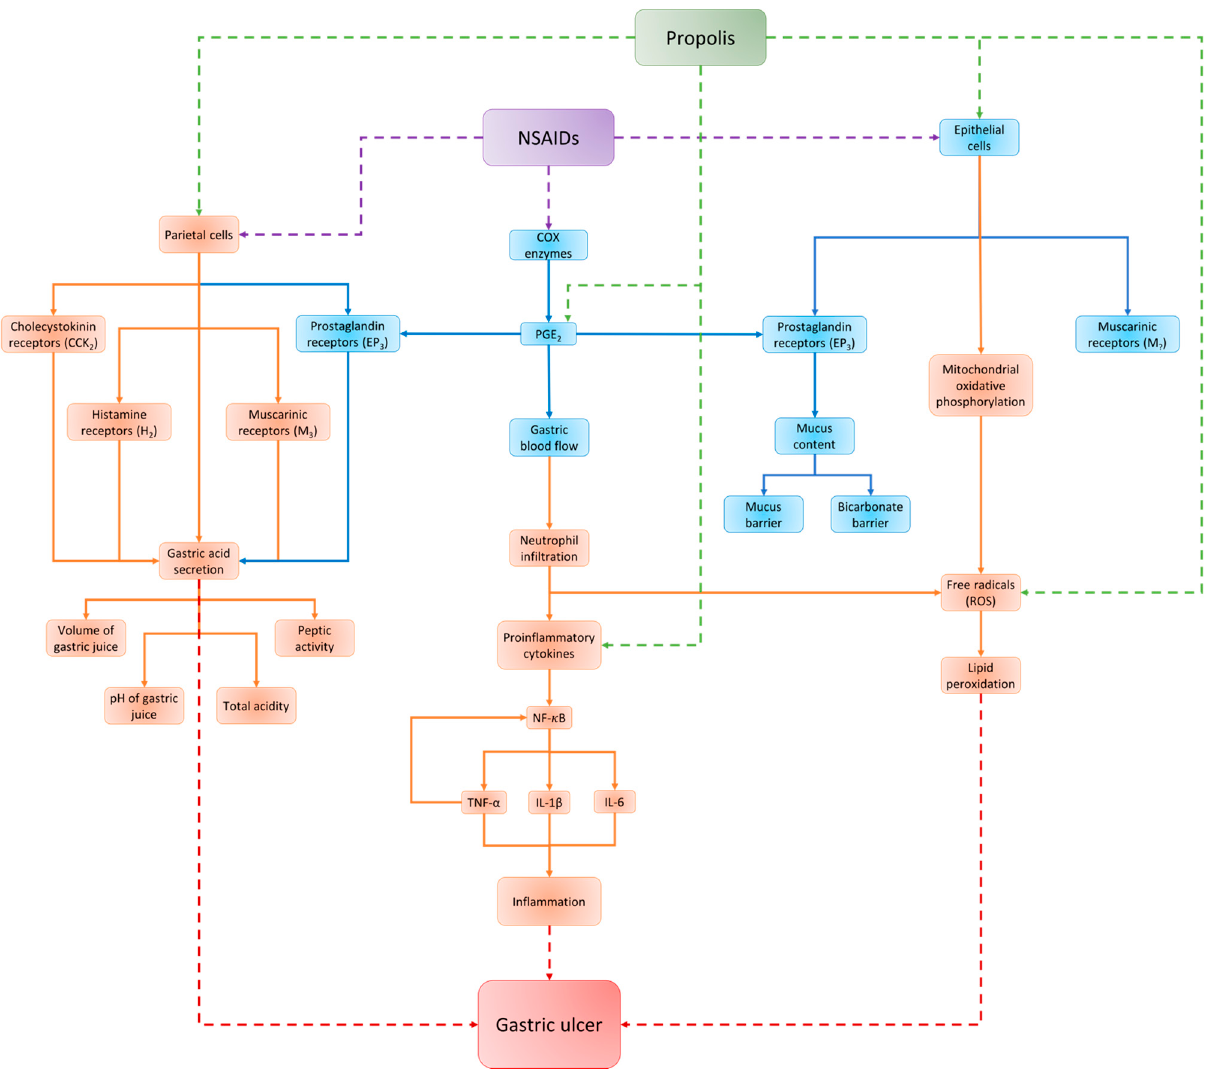
Figure 3. Harmful and protective factors implicated in the development of gastric ulcers. Blue boxes and arrows show the protective factors of the gastric mucosa, whereas orange boxes and arrows show harmful factors involved in the develop- ment of gastric ulcers. The purple dashed arrows and box show the level at which NSAIDs act to induce gastric ulcers in the gastric mucosa; on the other hand, the green dashed arrows and box show the different levels at which propolis can act to display its gastroprotective and antiulcerogenic properties. Finally, the red dashed arrows and box show the factors that lead to the development of gastric ulcers.